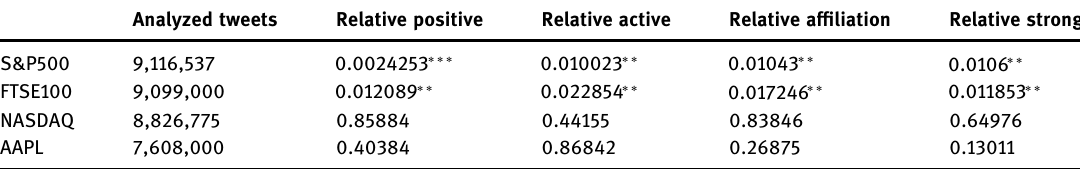
Table 1: F - statistics for the hypothesis H 0 : the changes in sentiment do not Granger cause the asset returns Analyzed tweets